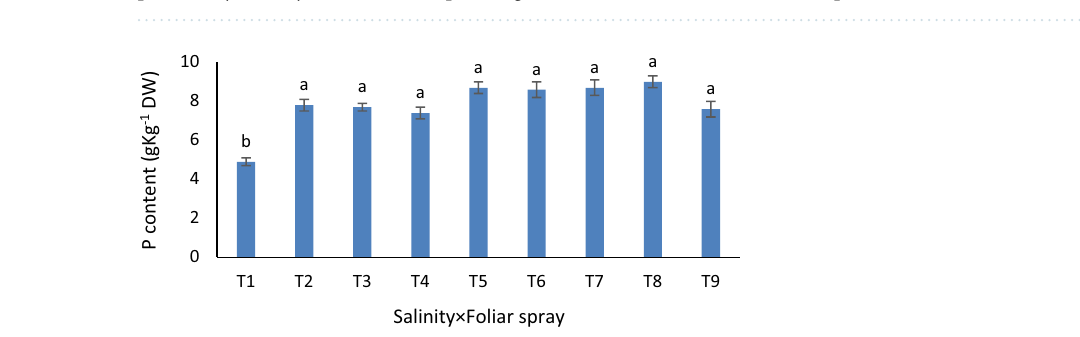
Figure 3. Mean comparisons for the effects of foliar spray of Fe and Se ( A ) and graphene oxide soil-based application ( B ) on K + /Na + in grapevine cv. Sultana. Similar letters show no meaningful difference at 5% probability level by Duncan’s Multiple Range Test. Data are mean ± SD (n = 3 replicates).